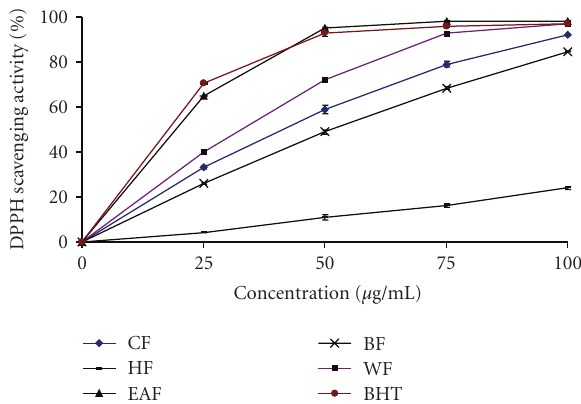
Figure 1: DPPH radical scavenging activity of the crude ethanol fraction (EF), hexane fraction (HF), ethyl acetate fraction (EAF), butanol fraction (BF) and water fraction (WF) from wampee